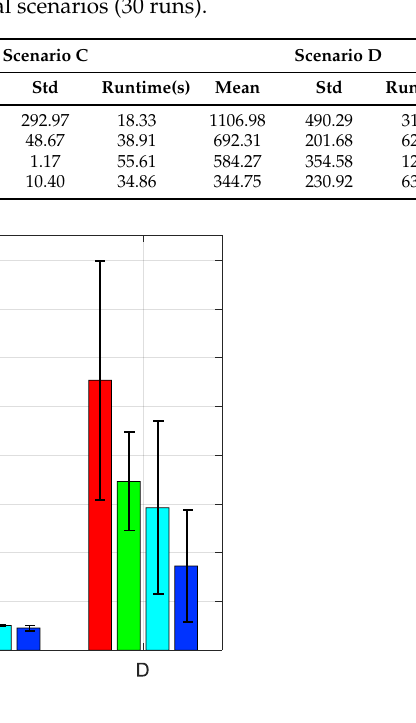
Figure 9. Performance comparison of algorithms among